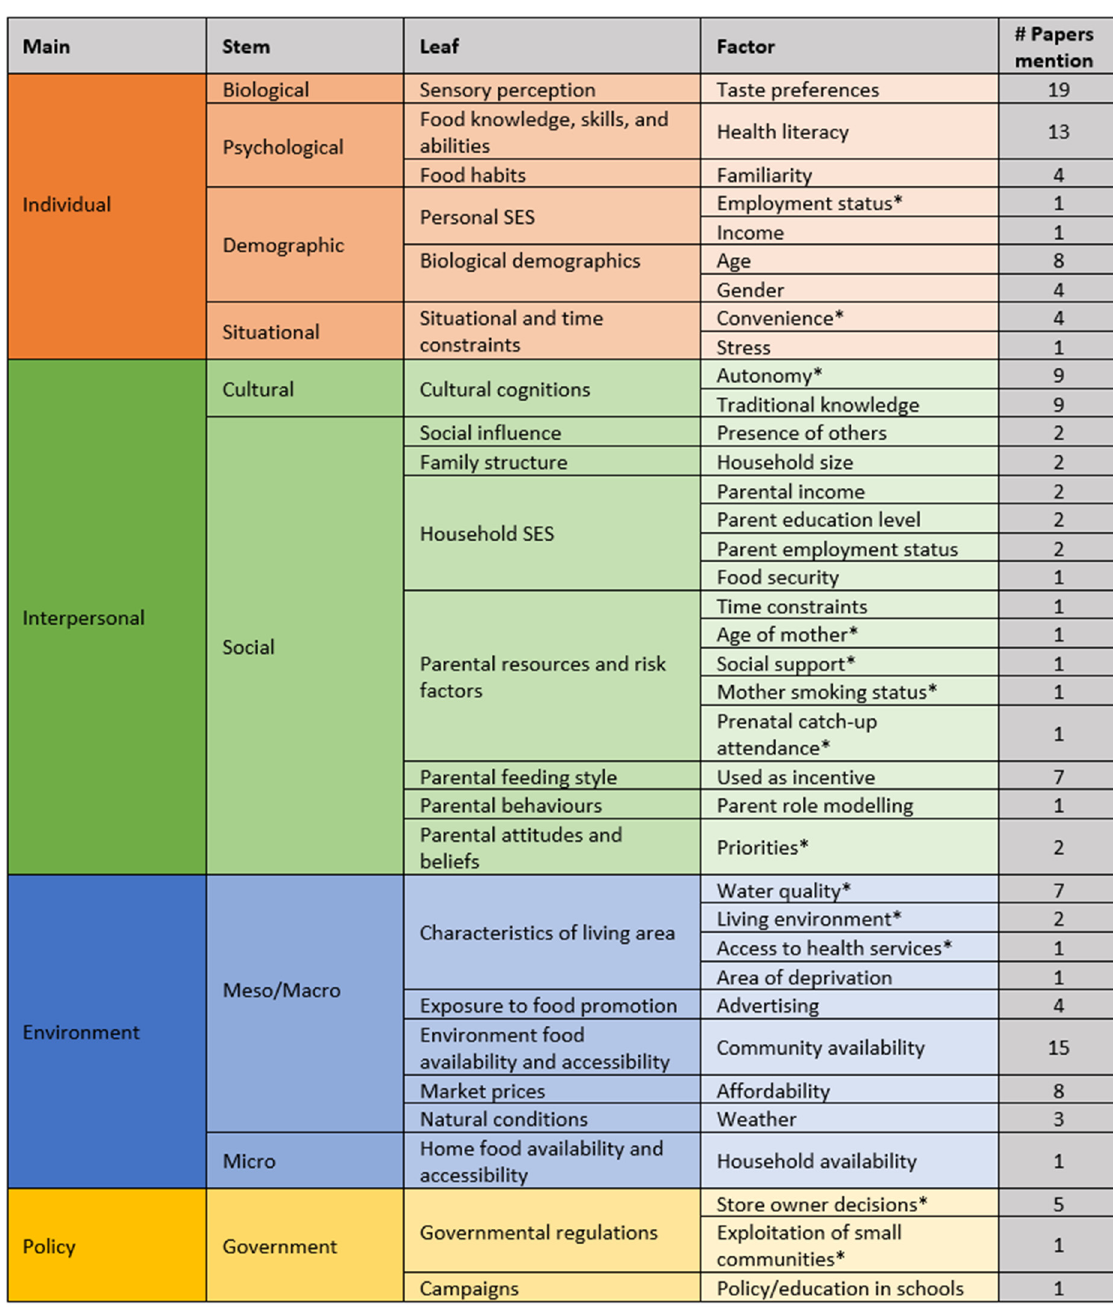
Figure 3. Factors grouped according to the DONE framework, where * indicates the factor is not currently identified within the DONE framework [32].